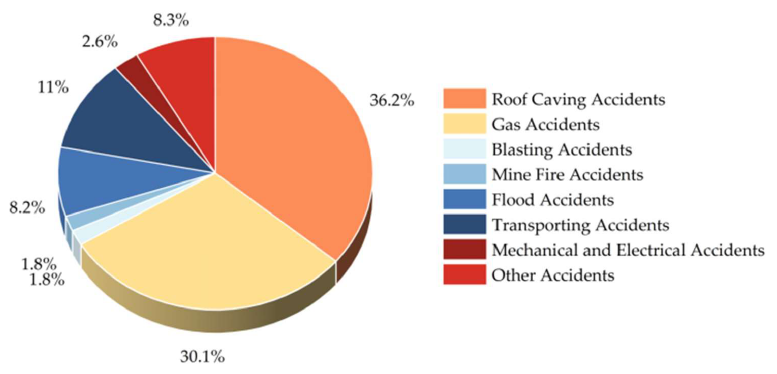
Figure 2. Proportion chart of the death toll in various coal mine accidents.